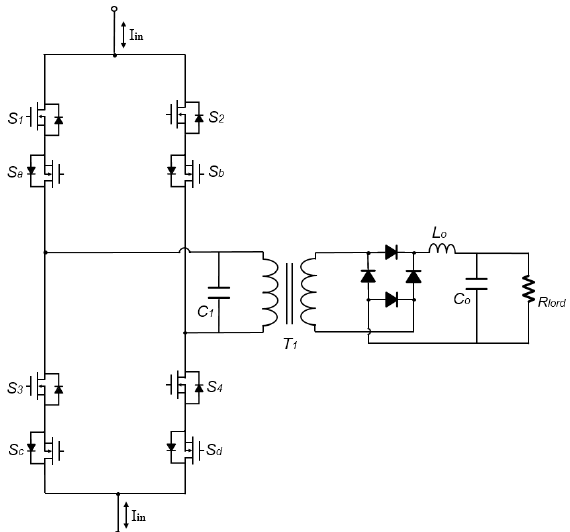
Figure 4. Circuit topology of the current-to-voltage converter.